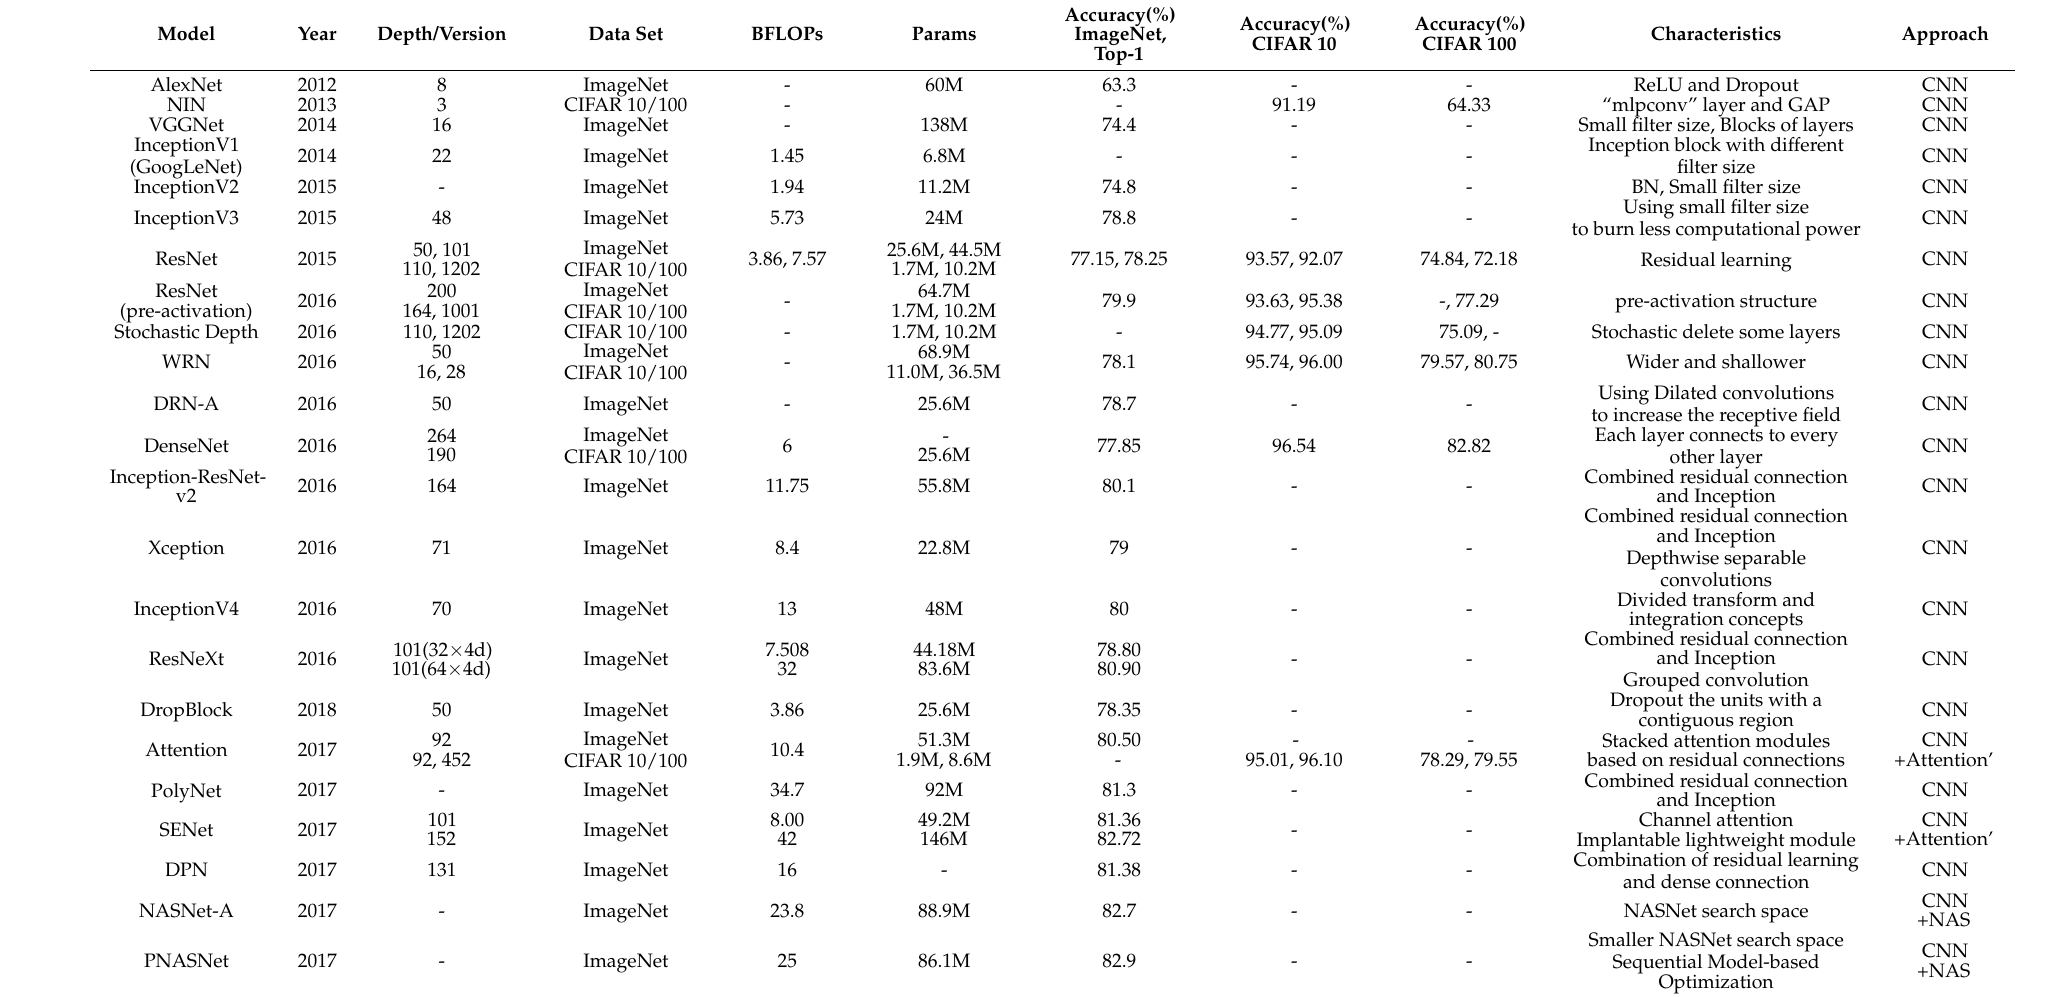
Table 3. Comparison of Various Image Classification